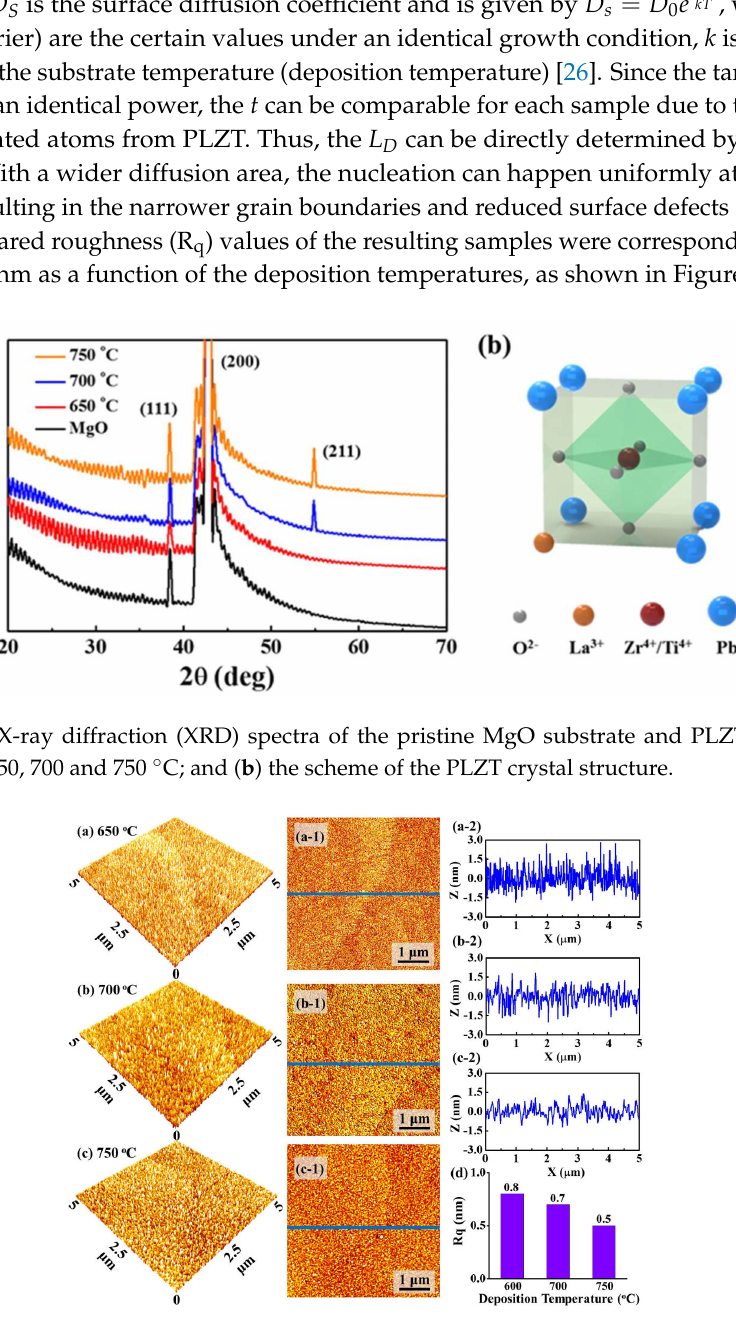
Figure 2. Atomic force microscopy (AFM) side-views of 5 × 5 µ m 2 for PLZT thin films on MgO (200) with various deposition temperatures: ( a ) 650; ( b ) 700; and ( c ) 750 ◦ C; ( a-1 – c-1 ) the corresponding top-views of 5 × 5 µ m 2 ; ( a-2 – c-2 ) cross-sectional line-profiles acquired from the area drawn with the blue lines in ( a-1 – c-1 ); and ( d ) the root mean squared roughness (R q ) values for PLZT thin films deposited at various deposition